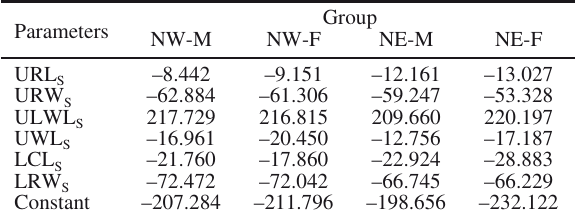
Table 5. – Coefficients of parameters in classification functions us- ing beaks as a material. Parameters